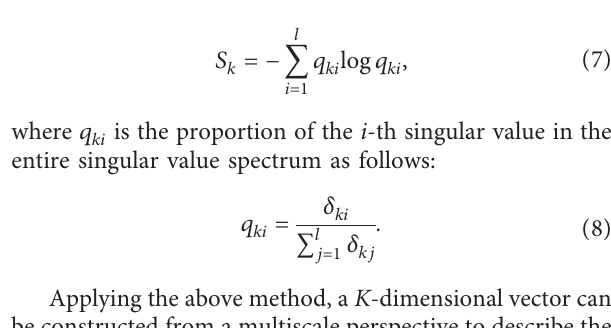
– u . (d) Decomposed spectral by EMD. (e) Decomposed 1 5